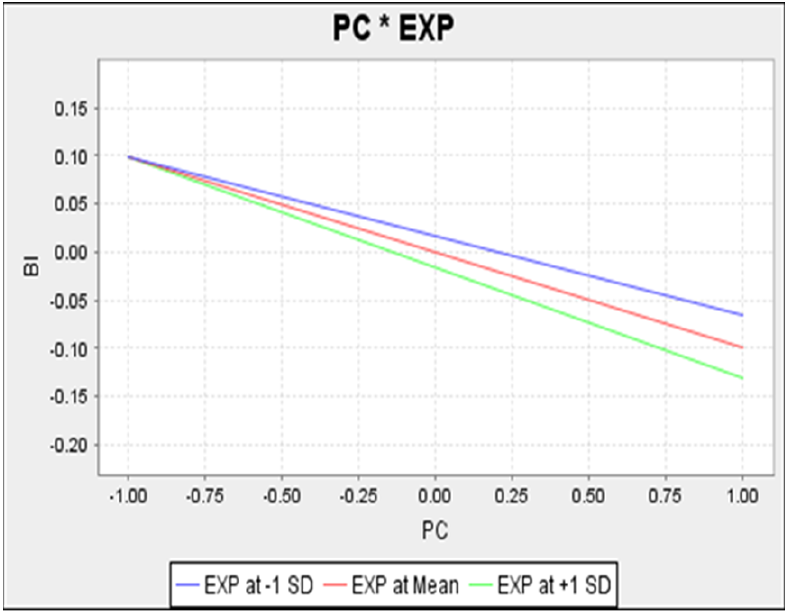
Figure 7. Simple Slope Analysis of Privacy Concern on Behavioural Intention.